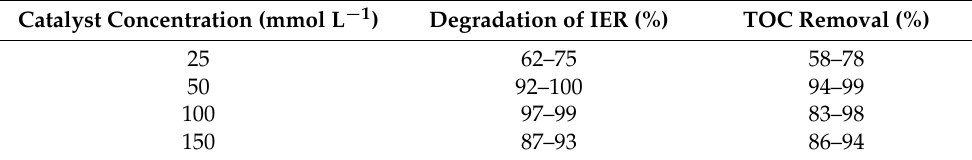
Table 3. Degradation of IER and Total Organic Carbon (TOC) in percentages.